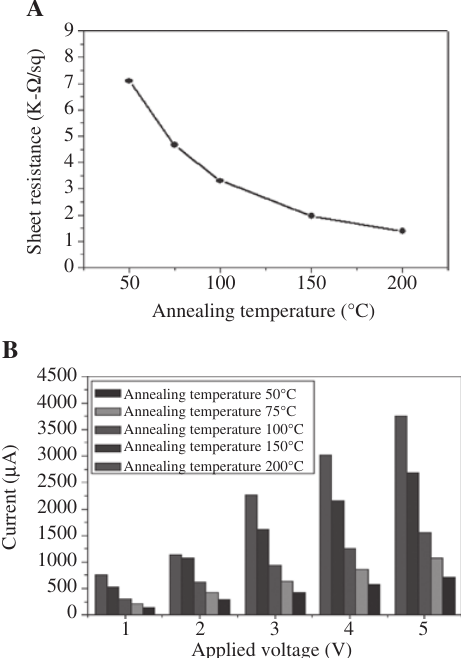
Figure 10: Electrical characterization. (A) Variation of sheet resistance as a function of annealing temperature of produced graphene. (B) The current-voltage (I–V) characteristics of graphene at different annealing